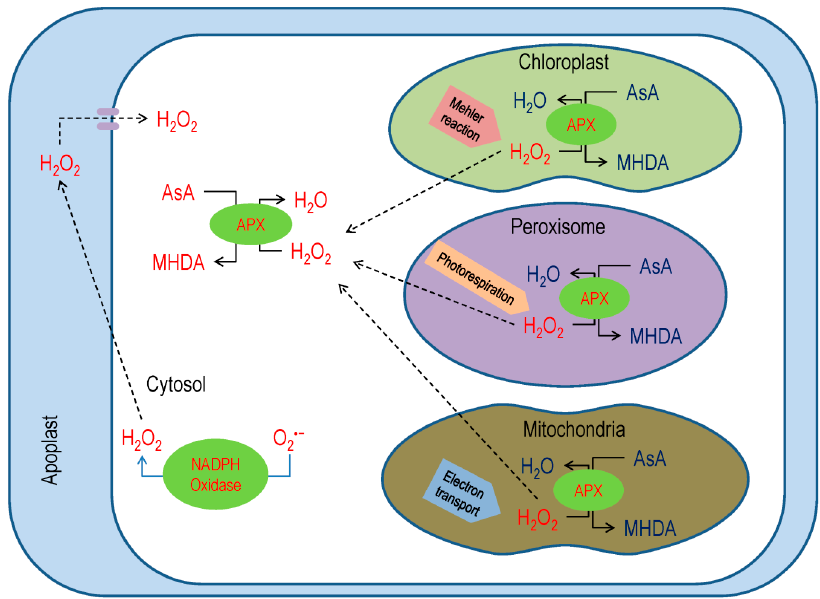
Figure 4. The function of Ascorbate peroxidase (APX) for the abolition of excess reactive oxygen species (ROS) generation in various cellular compartments. Additional details are in the text.